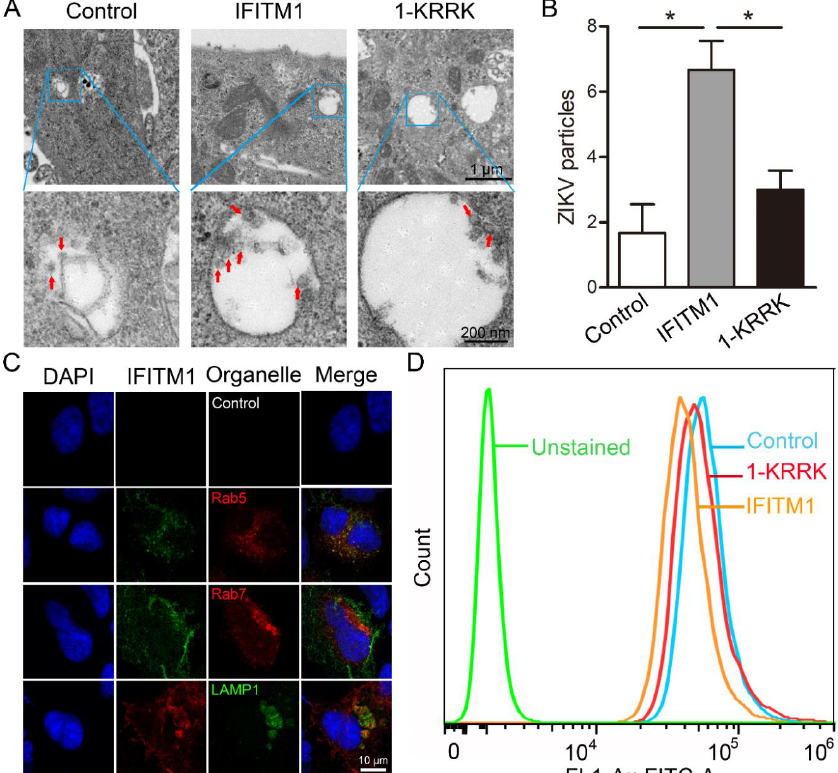
Figure 6. Restriction of IFITM1 on the release of ZIKV from endosome to cytosol by inhibiting the acidification of organelles. ( A , B ) The restriction of IFITM1 and 1-KRRK on the release of ZIKV